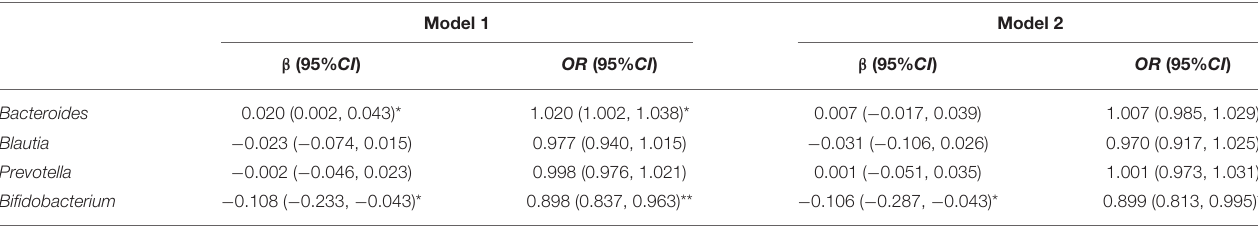
TABLE 3 | OR s with 95% CI s for the association between differential gut microbial genera and the risk of